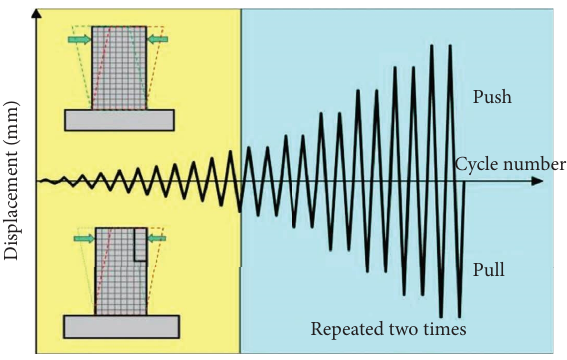
Figure 13: Loading